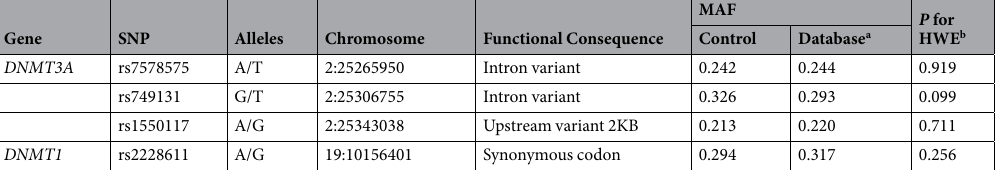
Table 2. General information of selected SNPs and Hardy-Weinberg test. a Data from NCBI dbSNP. b P value of Hardy-Weinberg